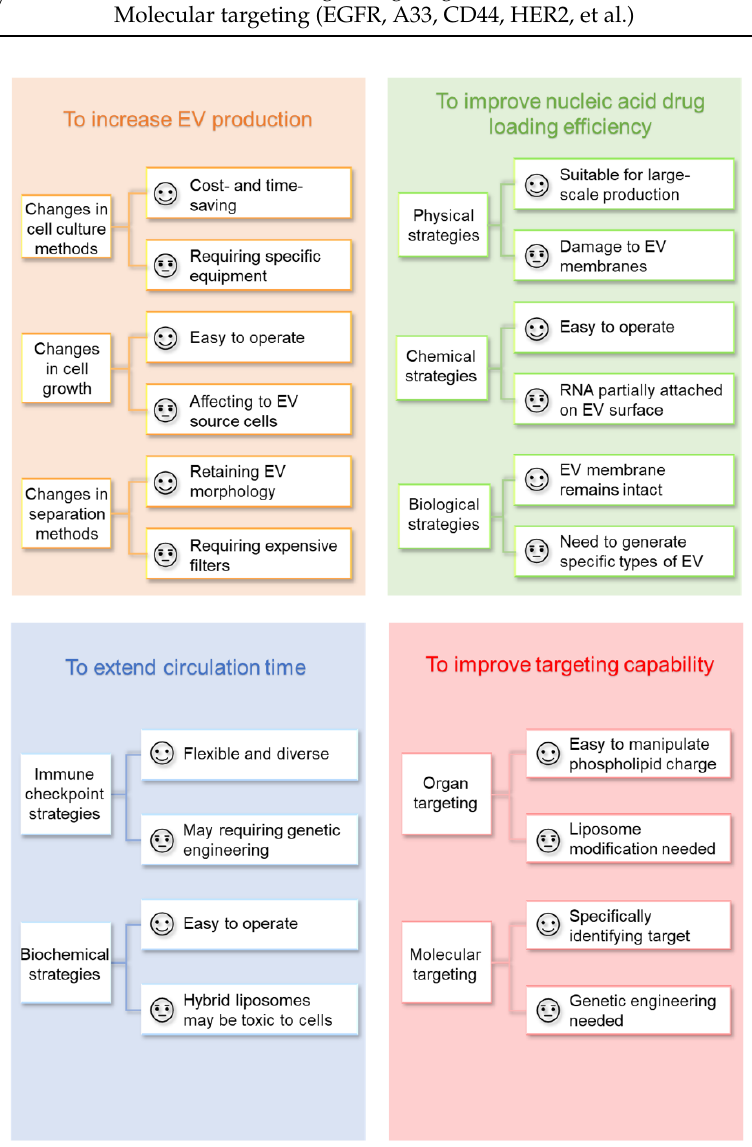
Figure 1. Summary of different modification strategies for EVs. ( A ) to increase EV production; ( B ) to improve nucleic acid drug loading efficiency; ( C ) to extend circulation time; ( D ) to improve tar- geting capability. (Created with BioRender.com, accessed on 23 August 2022).